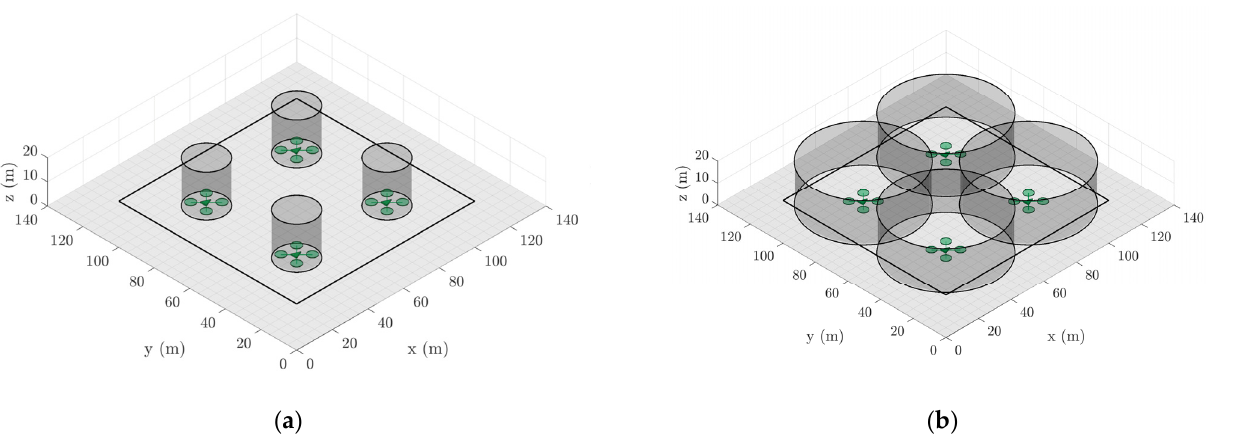
Figure 4. Sample arrangement involving four UAVs with different spatial constraints and operating regions imposed by their tether lengths. ( a ) No height constraints are necessary for this configura- tion. ( b ) The set heights should be different in this configuration to avoid collisions.